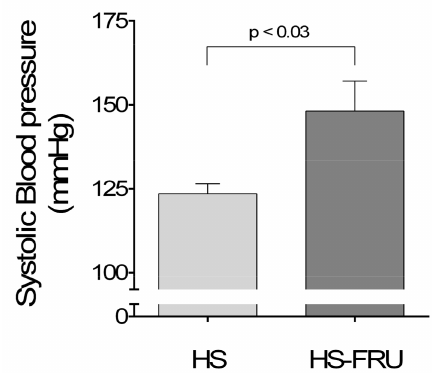
Figure 1. Effect of drinking 20% fructose for 7 days while on a high-salt diet on systolic blood pressure. Rats fed a high-salt diet drinking tap water (HS) or 20% fructose (HS-FRU).